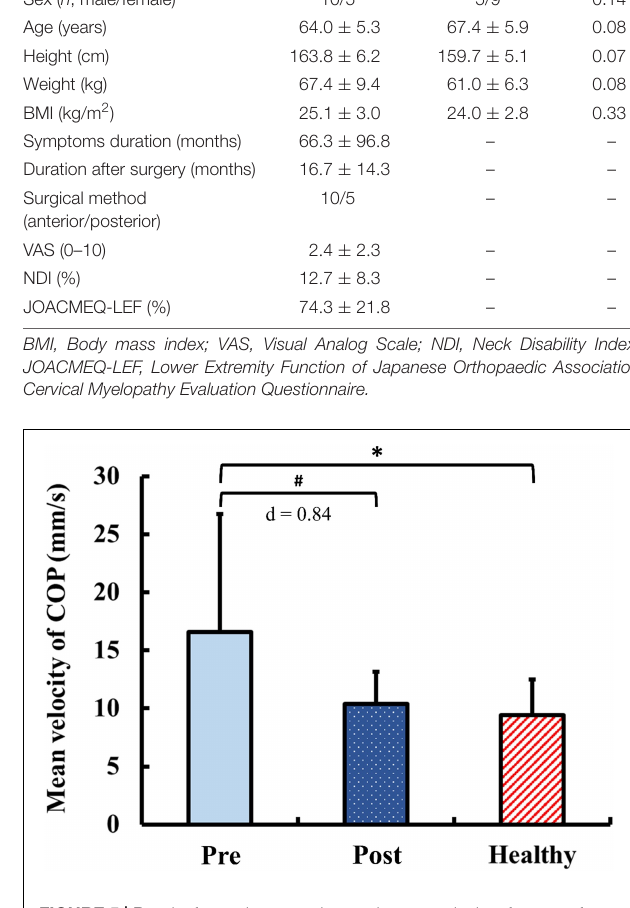
FIGURE 5 | Results for static postural control: mean velocity of center of pressure (COP) during quiet standing with eyes closed. The symbol “ ∗ ” indicated a significant difference between the DCM group and the healthy control group: p < 0.05. The symbol “#” Indicated a significant difference in the DCM group before and after training: p < 0.05.